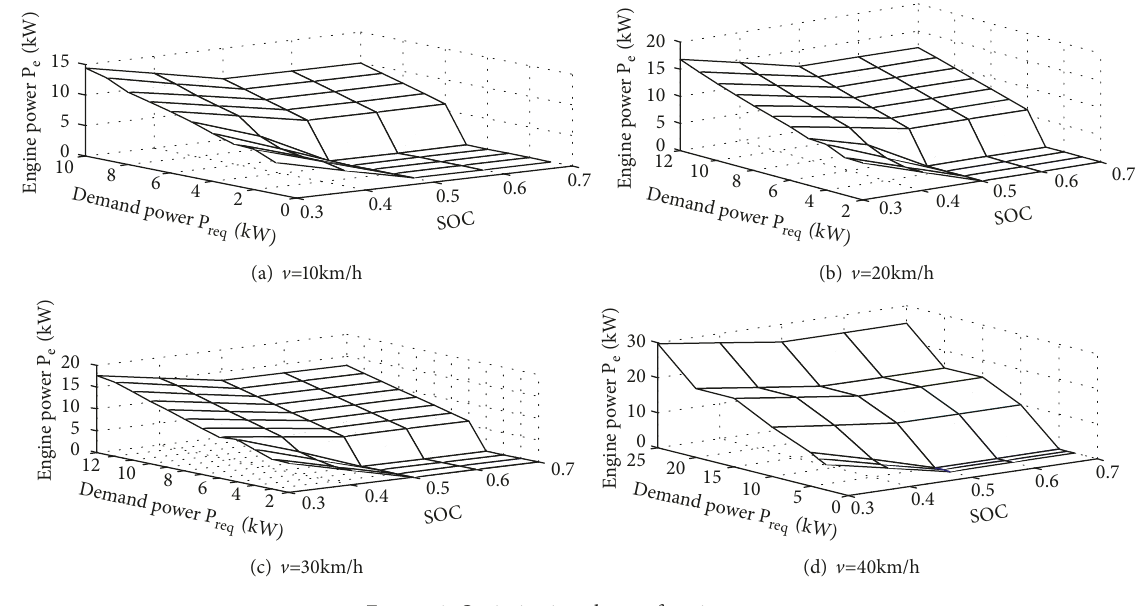
Figure 9: Optimization charts of engine power.